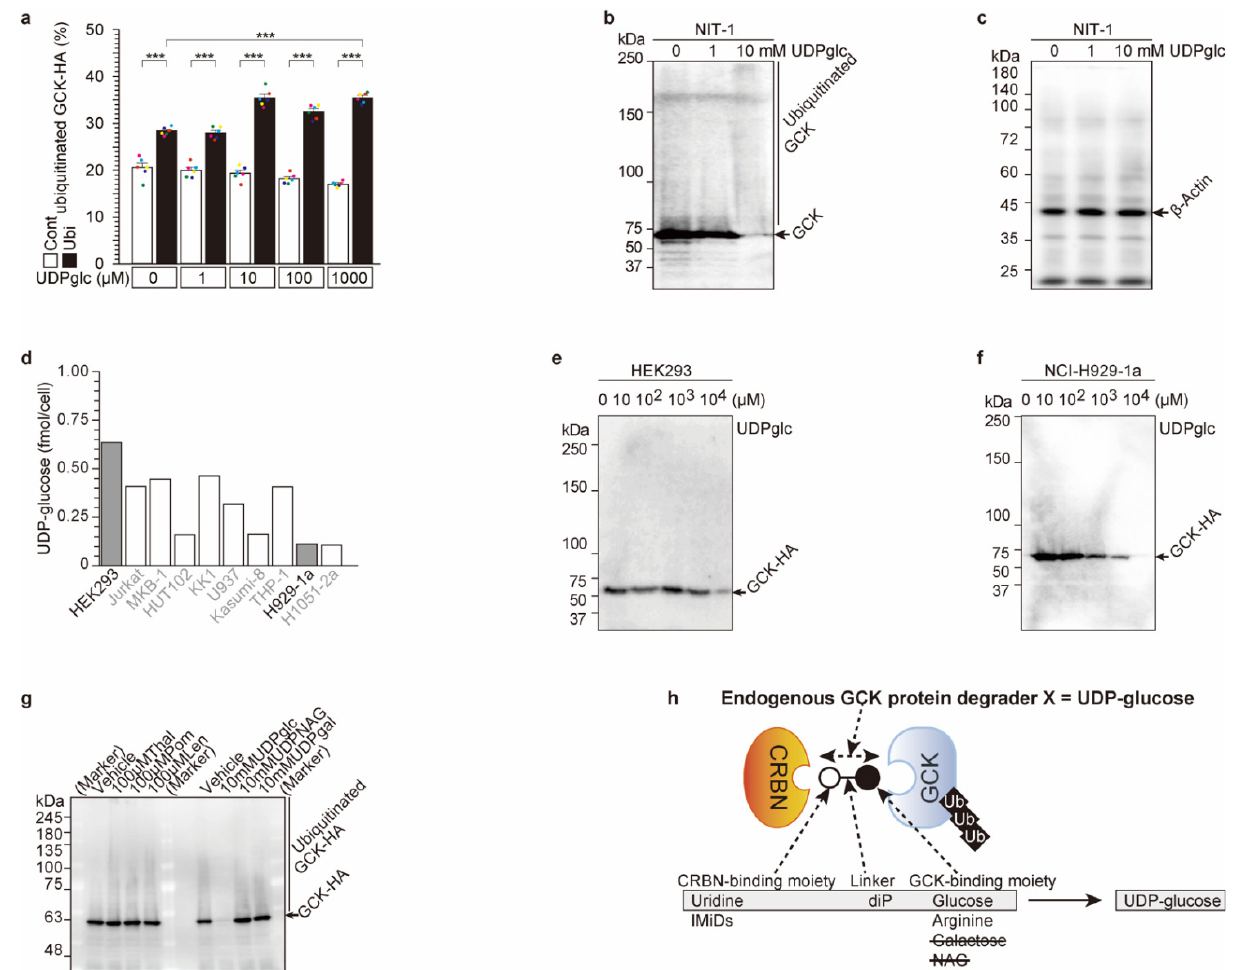
Figure 3. UDP-glucose induces cereblon-dependent glucokinase ubiquitination and degradation. ( a ) UDP-glucose induces glucokinase ubiquitination in a dose-dependent manner. The HEK 293 cells were transfected with HA-tagged glucokinase (GCK-HA), FLAG-tagged cereblon (CRBN-F), and Myc-tagged ubiquitin (ubi-Myc) expression vectors for one day, and then UDP-glucose was added for 3 h. Intracellular GCK-HA was detected by WB (Figure S3a). Ubiquitinated GCK-HA (per total GCK-HA, %) was calculated and plotted. The values are reported as the means ± standard error (n = 6) with six individual data points. ***; p < 0.0001. ( b , c ) NIT-1 cells were treated with UDP- glucose for 3 h, the cells were harvested, and endogenous glucokinase proteins were detected by WB ( b ). Control β -actin WB is ( c ). ( d – f ) Both endogenous and administrated UDP-glucose regulated GCK-HA protein degradation. The endogenous UDP-glucose concentration was measured in vari- ous cell lines ( d ). Ten mM UDP-glucose administration reduced GCK-HA protein degradation in HEK293 cells ( e ). One hundred μ M UDP-glucose administration reduced GCK-HA protein degra- dation in NCI-H929-1a cell ( f ). ( g ) UDP-glucose induces glucokinase degradation among UDP-mon- osaccharides (glucose, galactose and NAG) and IMiDs. ( h ) Graphic summary; Endogenous gluco- kinase protein X was UDP-glucose.